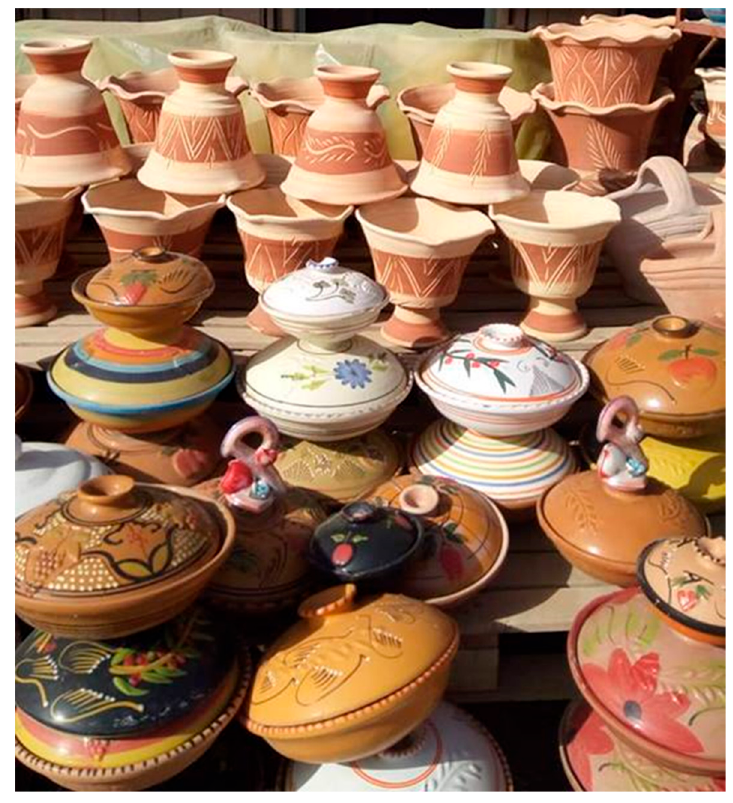
Figure 8. Clay vessels in Gharyan.